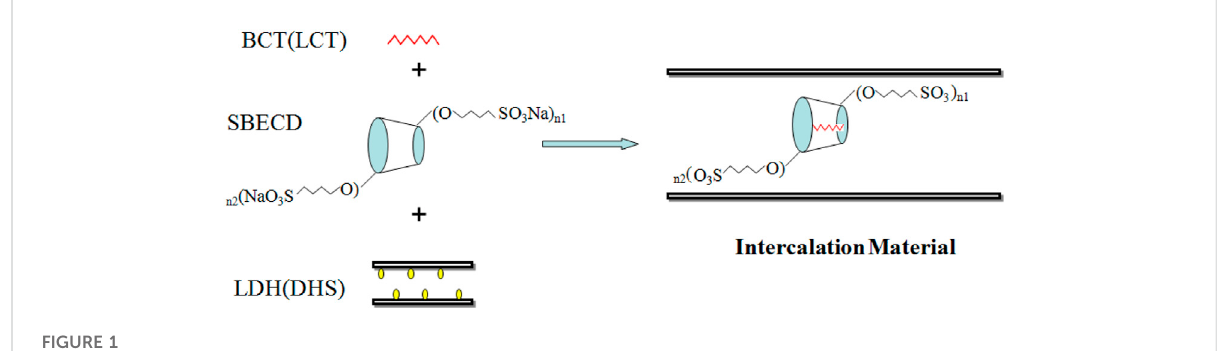
FIGURE 1 Preparation schematics of the hybrids (SBECD, n 1+ n 2 =